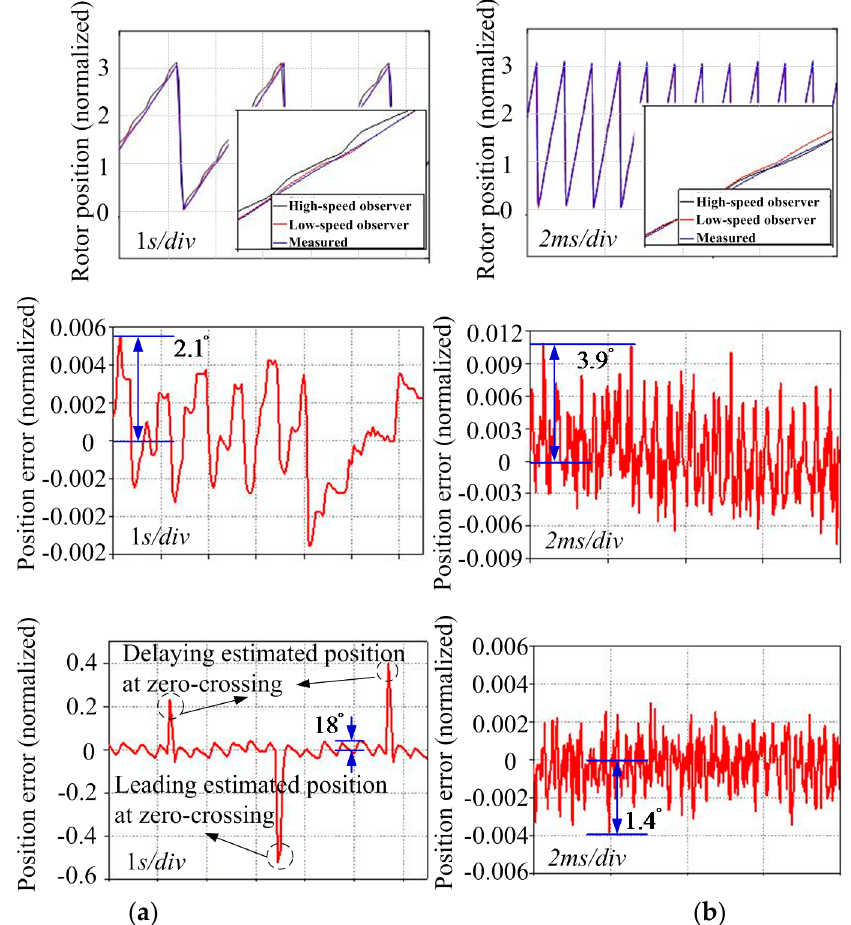
Figure 11. Position estimation and its error ( a ) start-up estimation algorithm ( b ) operation estimation